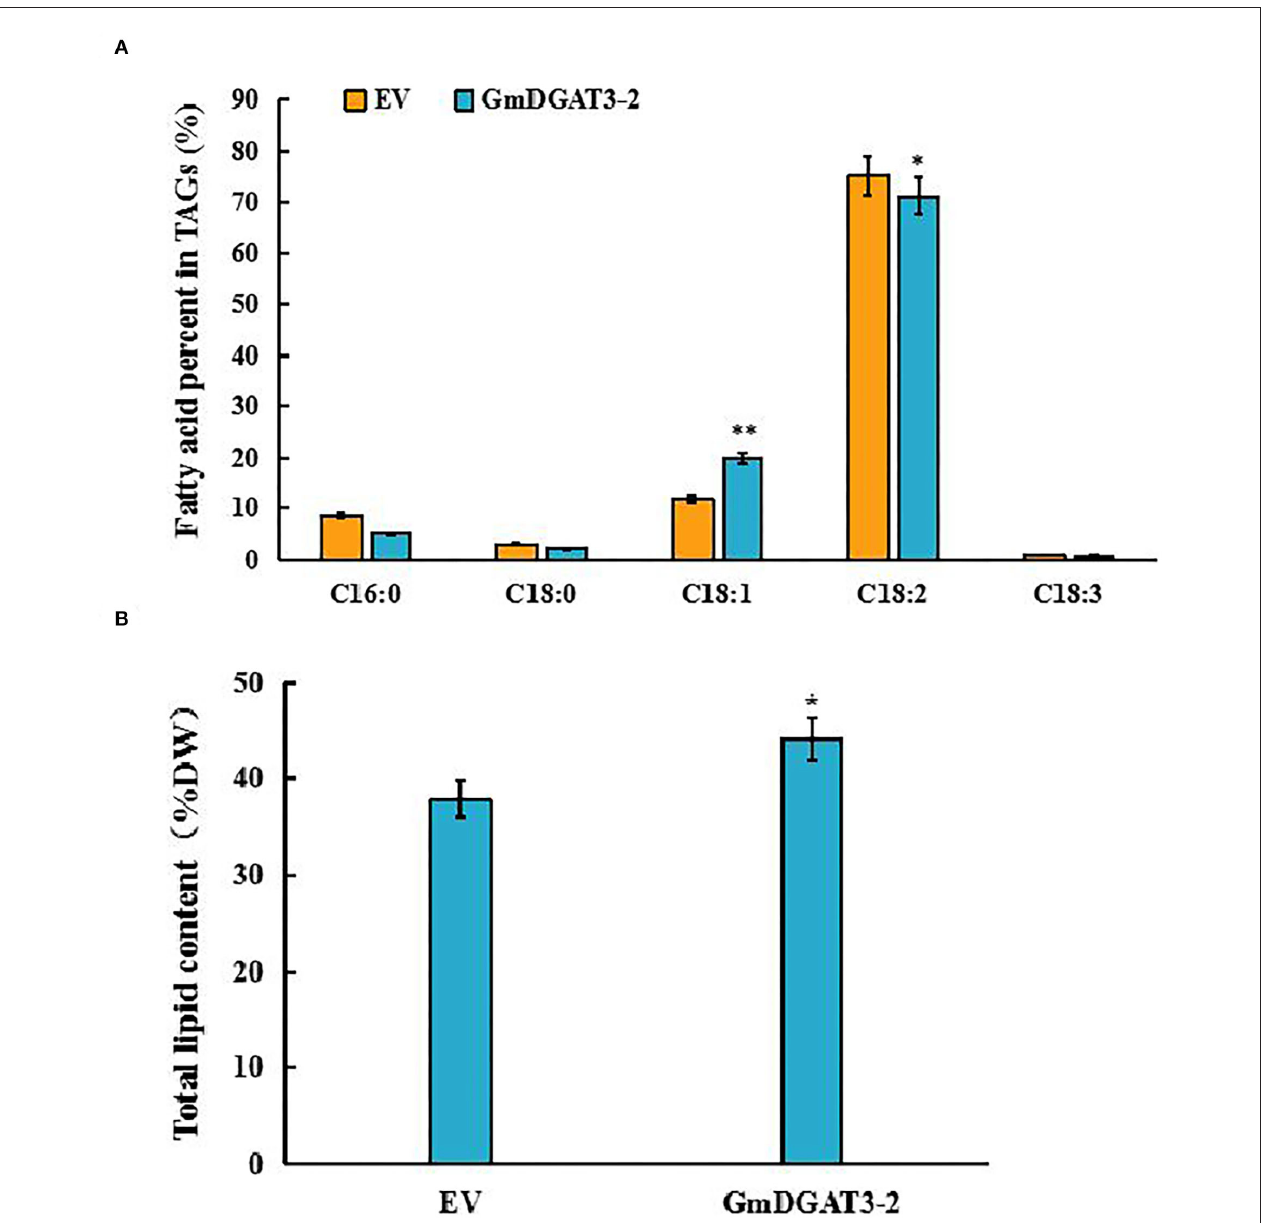
FIGURE 8 | Major fatty acid profiles (A) and total lipid content (B) in tobacco seeds of transgenic tobacco expressing GmDGAT3-2 and empty vector, respectively. GmDGAT3-2, GmDGAT3-2 transgenic tobacco plants; EV, empty vector transformed tobacco plants. The bars were means and SD s of three biological repeats. Asterisks indicate significant difference from the EV according to t -test at ** P < 0.01, and * P < 0.05,